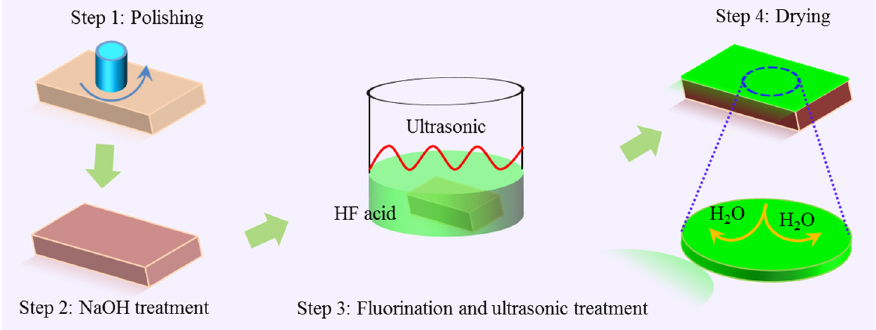
Figure 1. Schematic illustration showing the preparation process of ultrasonically treated fluoride coating on Mg alloy.